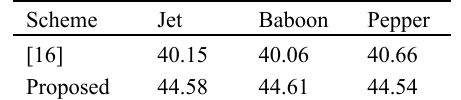
Table 1. PSNRs of stego-image for [16] and proposed scheme. Scheme Jet